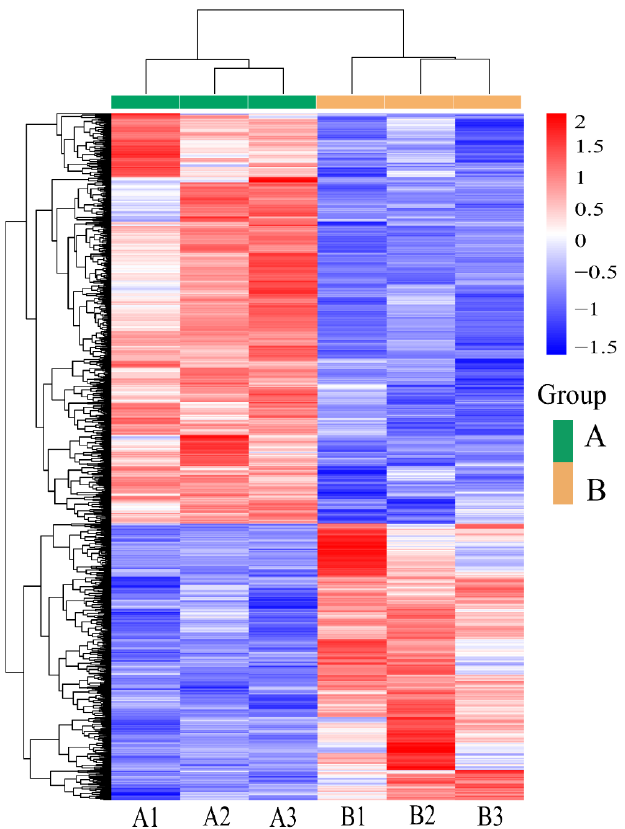
Figure 1. Clustering heat map of DEGs among the samples. The abscissa is the sample name, and the ordinate is the normalized value of the differential gene FPKM (Z-score). The redder the colour, the higher the expression level, and the bluer the colour, the lower the expression